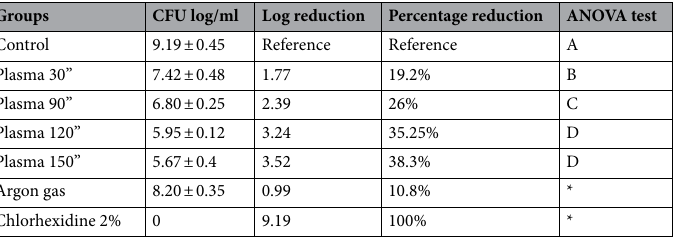
Table 2. Effect of plasma application on S.mutans biofilm (Log CFU/ml). Groups having similar letters are not significantly differences ( p > 0.05), *Indicates significantly differences with all the